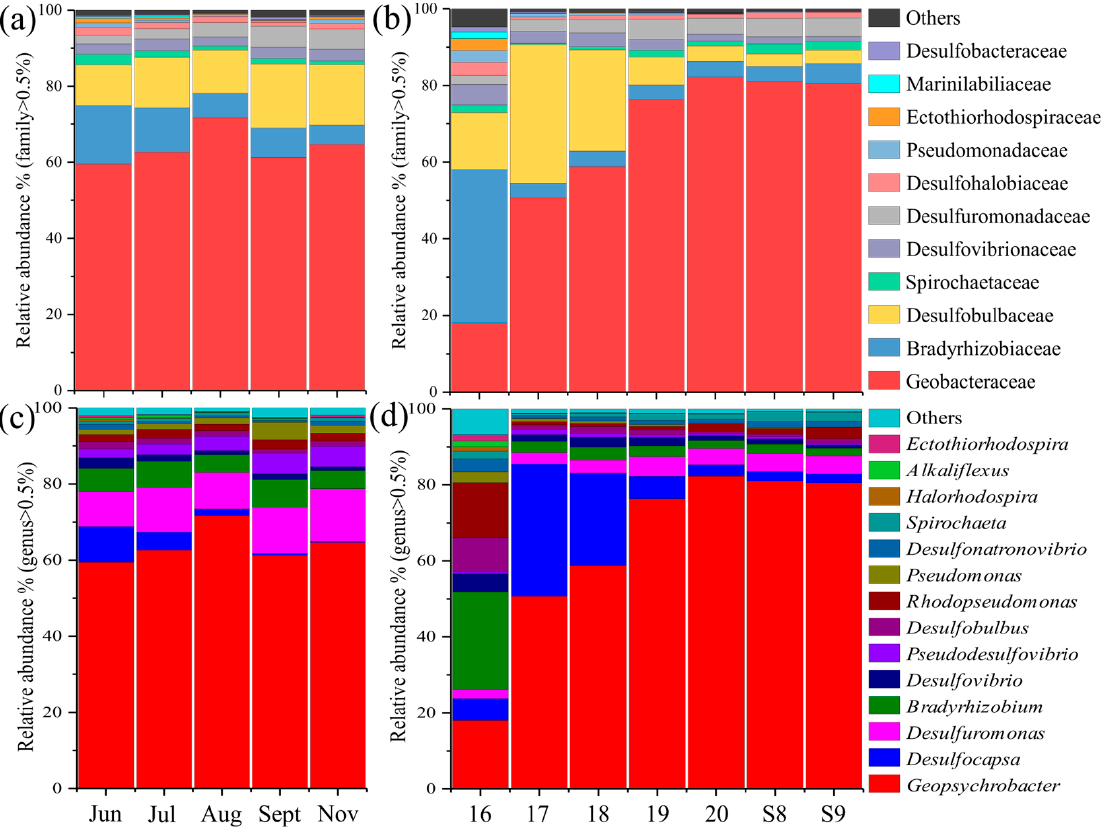
Figure 4. Columnar stacking diagram reflecting the relative abundance of the main taxa (average relative abundance > 0.5% across all samples) in nifH gene communities at the family ( a , b ) and genus levels ( c , d ).